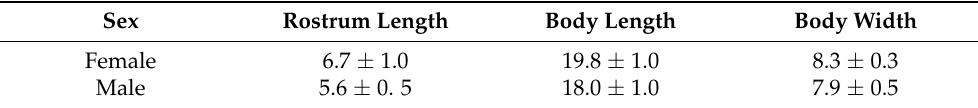
Table 1. Morphometric features of Aclees taiwanensis male and female adults.